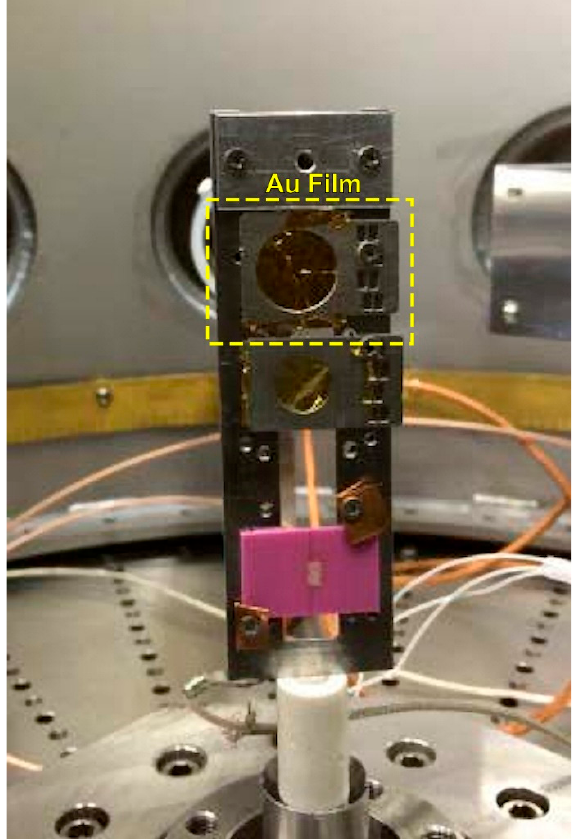
Figure 5. Au film for heavy ion-beam scattering.